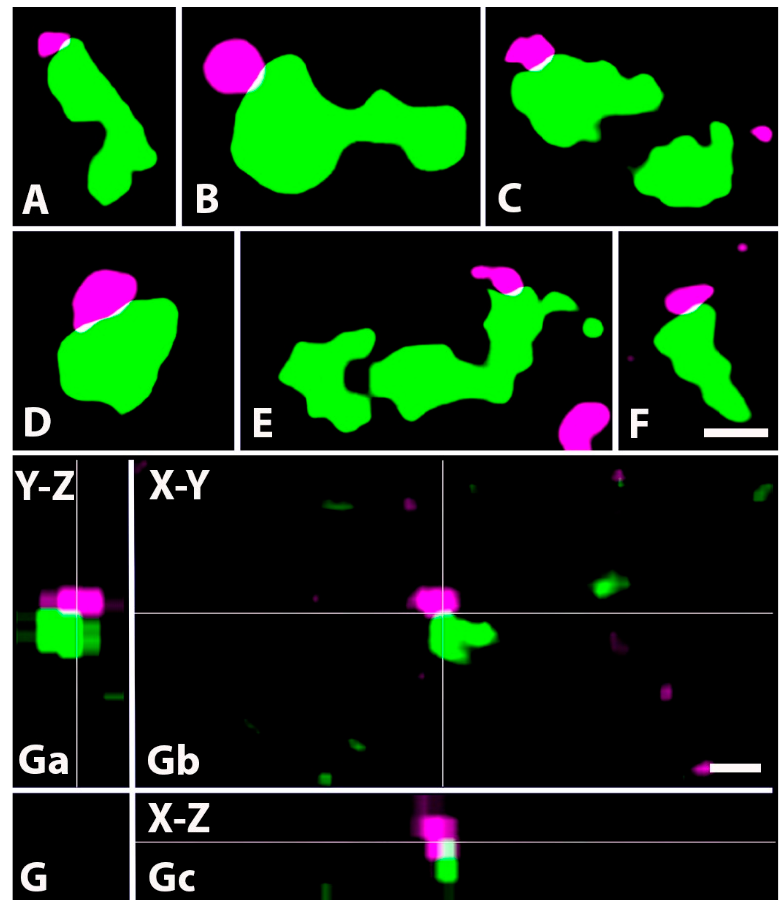
Figure 8. Close appositions between axon terminals immunoreactive for GlyT2 and VGLUT1. ( A – F ). Micrographs of 1 µm thick laser scanning confocal optical sections showing close appositions between axons immunoreactive for GlyT2 (magenta) and VGLUT1 (green), a marker for nonnociceptive pri- mary afferents. Note the thin contact zones (yellow) between the two types of labeled axon terminals, which may represent axo-axonic synapses observed with electron microscopy. ( G ). Micrographs of a short series of confocal optical sections double immunostained for GlyT2 (magenta) and VGLUT1 (green) showing contact between GlyT2 (magenta) and VGLUT1 (green) immunostained axon termi- nals shown in X-Y (Gb), X-Z (Ga) and Y-Z (Gc) projections. The contact zone between the two labeled axon terminals (yellow) is at the crossing point of two lines indicating the planes through which orthogonal views of the X-Z and Y-Z projections were drawn. Note that the contact zone between the two labeled axon terminals (yellow) can be identified in all three orthogonal images. Scale bars: 0.5 µ m ( A – F ) and 1 µ m ( G ).